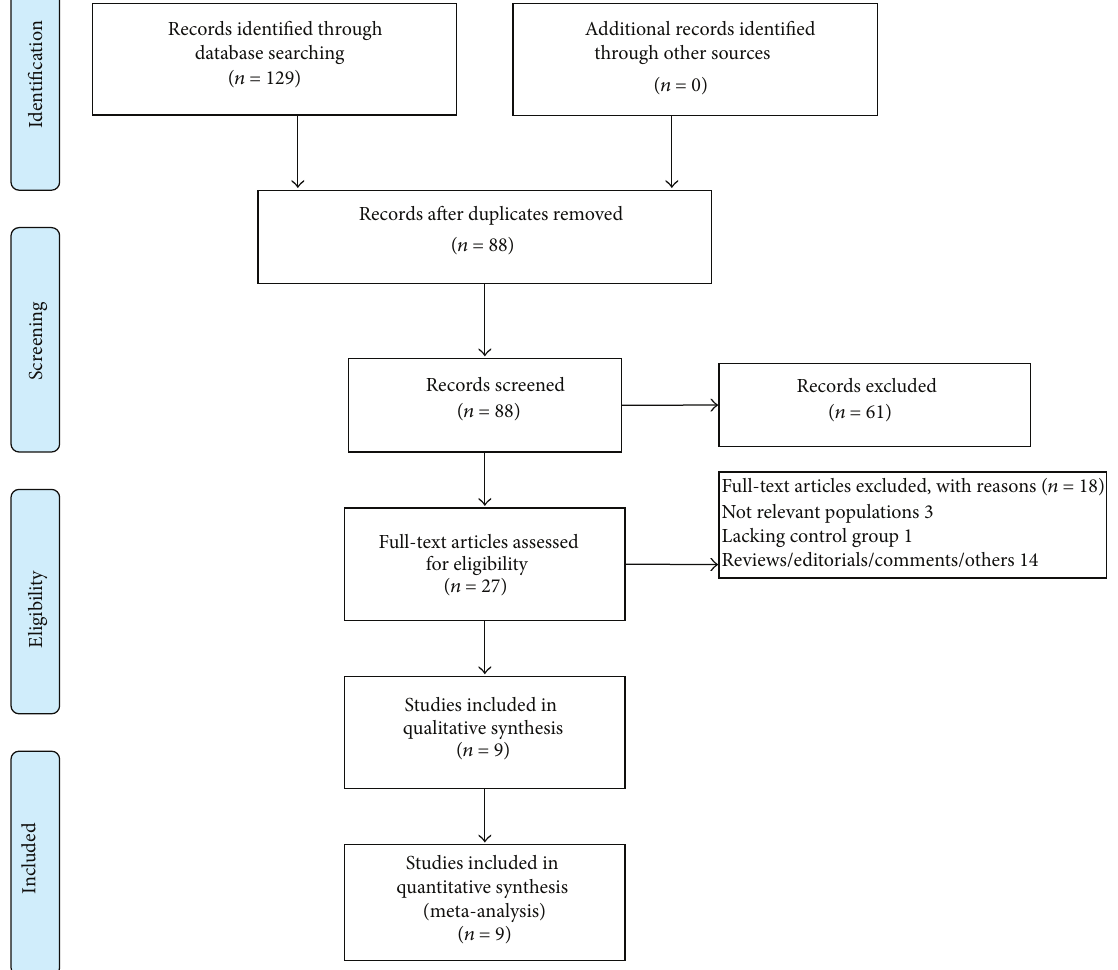
Figure 1: Flow diagram of study